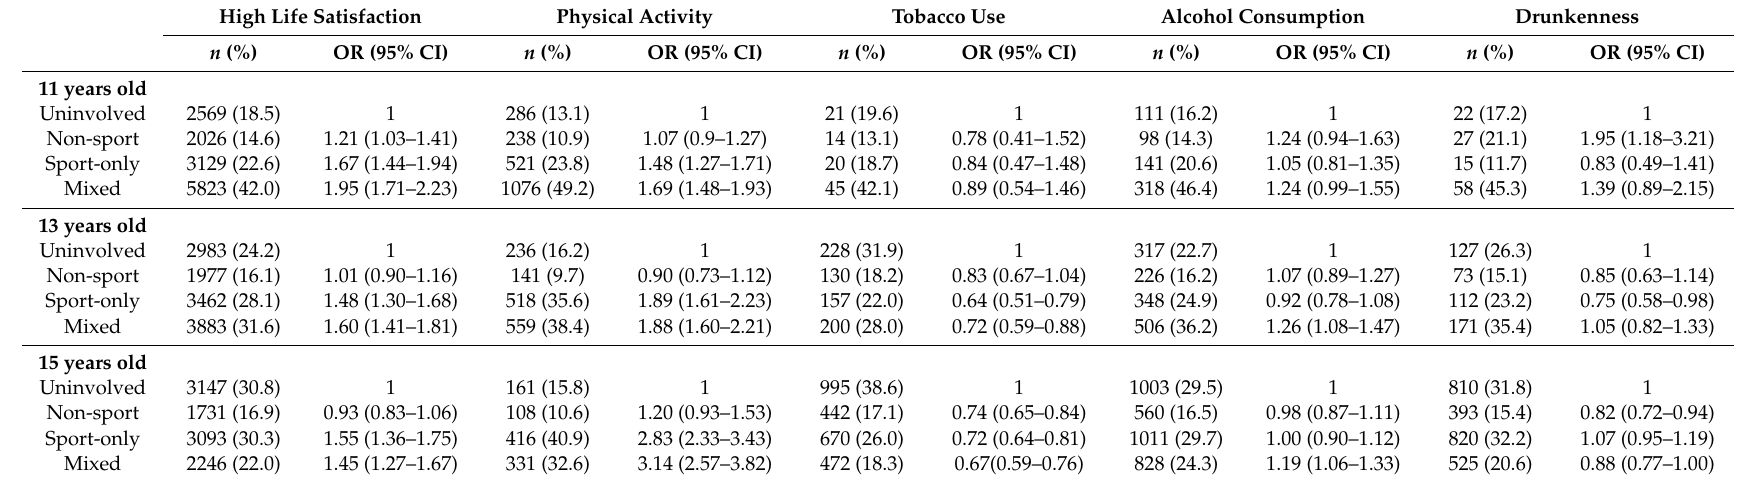
Table 2. Multilevel logistic regression analyses of involvement in organised leisure time activities (OLTA) and study outcomes § . Health Behaviours in School-aged Children (HBSC), Italy